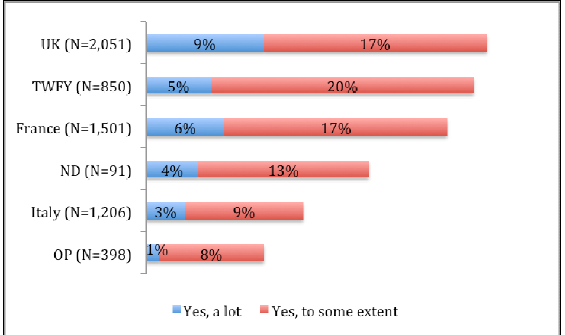
Figure 3. Respondents with health problems and disabilities compared to country